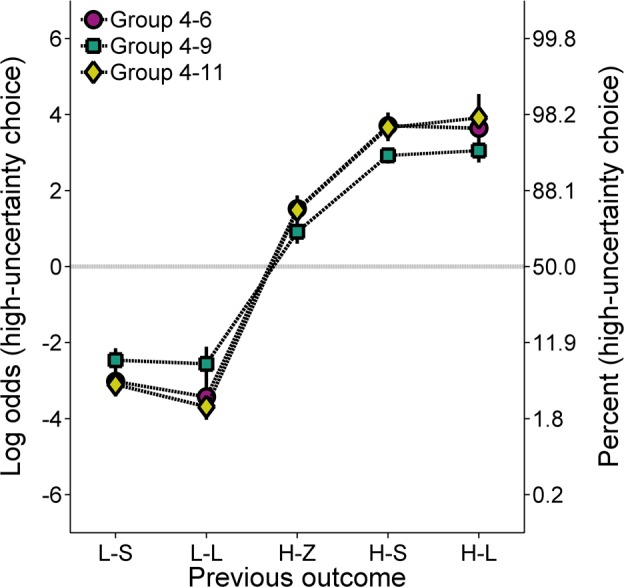
Mean (±SEM) log odds of high-uncertainty choices for each group in Experiment 2 as a function of the outcome of the previous choice, collapsed across the probability of high-uncertainty food delivery.A second ordinate showing percentages corresponding to the log odds values was included to aid interpretation. L-S = low-uncertainty-small; L-L = low-uncertainty-large; H-Z = high-uncertainty-zero; H-S = high-uncertainty-small; H-L = high-uncertainty-large.